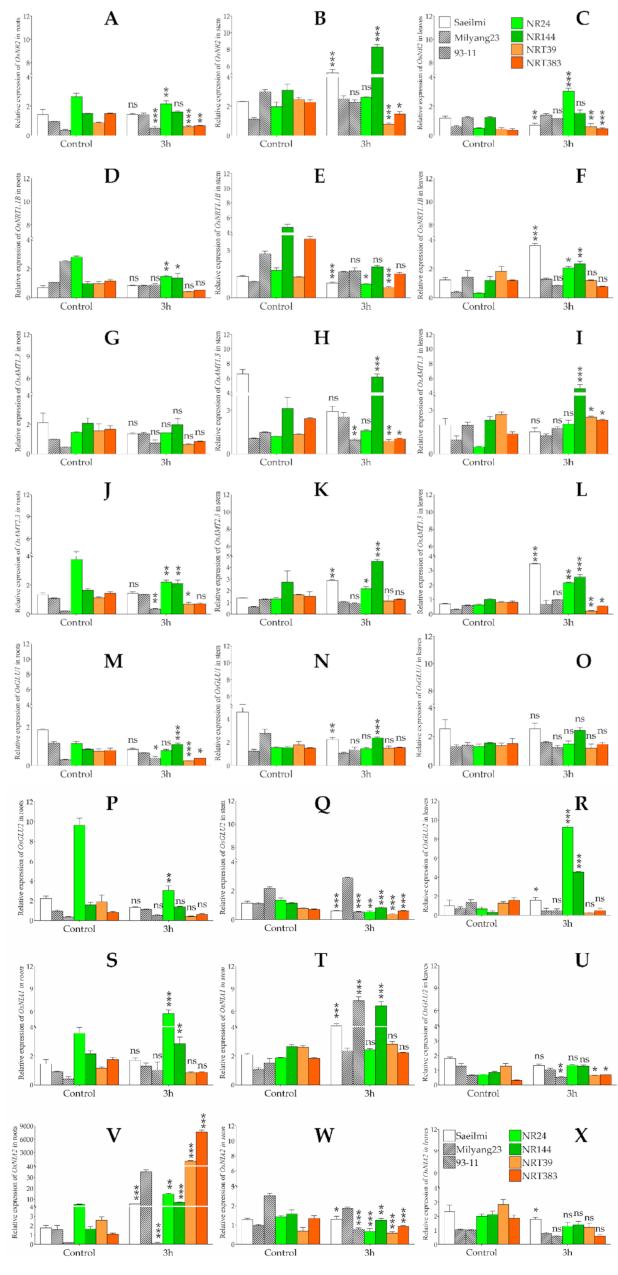
Figure 6. Transcriptional patterns of major nitrogen use efficiency (NUE) genes in different rice tissues under potassium chlorate (KClO 3 ) treatment. Transcriptional patterns of major NUE genes in different rice tissues under potassium chlorate treatment. ( A – C ) Transcriptional pattern of OsNR2 in the roots, stem, and leaves of three week-old nitrate reductase (NR) and nitrate transporter (NRT) introgression rice lines in response to 0.05% potassium chlorate (KClO 3 ), soon after treatment. ( D – F ) Transcript accumulation of OsNRT1.1B , ( G – I ) OsAMT1.3 , ( J – L ) OsAMT2.3 , ( M – O ) OsGLU1 , ( P – R ) OsGLU2 , ( S – U ) OsNIA1 , and ( V – X ) OsNIA2 under the same conditions. Bars are mean values of triplicates ± SE. *** p < 0.001, ** p < 0.01, * p < 0.05, ns non-significant. Data were compared with the expression level of Milyang23 (P2, KClO 3 sensitive) for the statistical